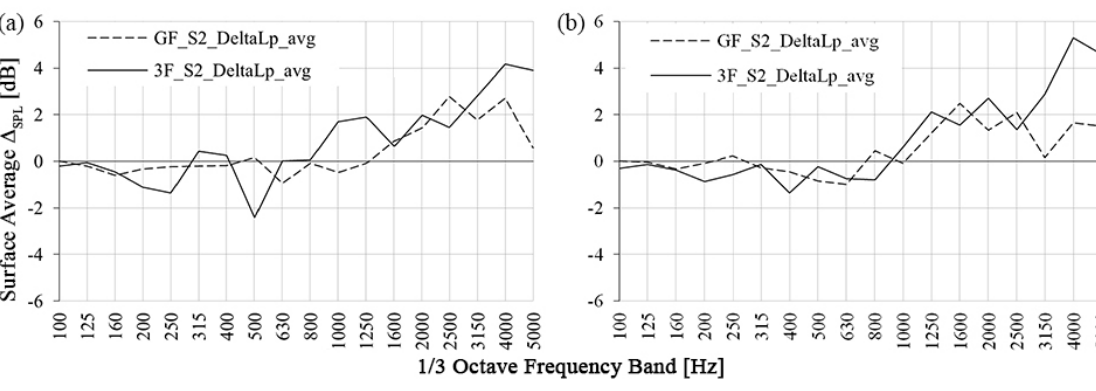
Figure 10. Δ SPL calculated between SPL on the glass surfaces of windows averaged over all the microphone positions. Ground floor (dashed line) and third floor (solid line). Source position in S1 , as it is in Figure 4. ( a ) Δ SPL = A SPL − C1 SPL ; ( b ) Δ SPL = A SPL − C2 SPL . Configurations A, C1, C2 are as they are in Figure 3.